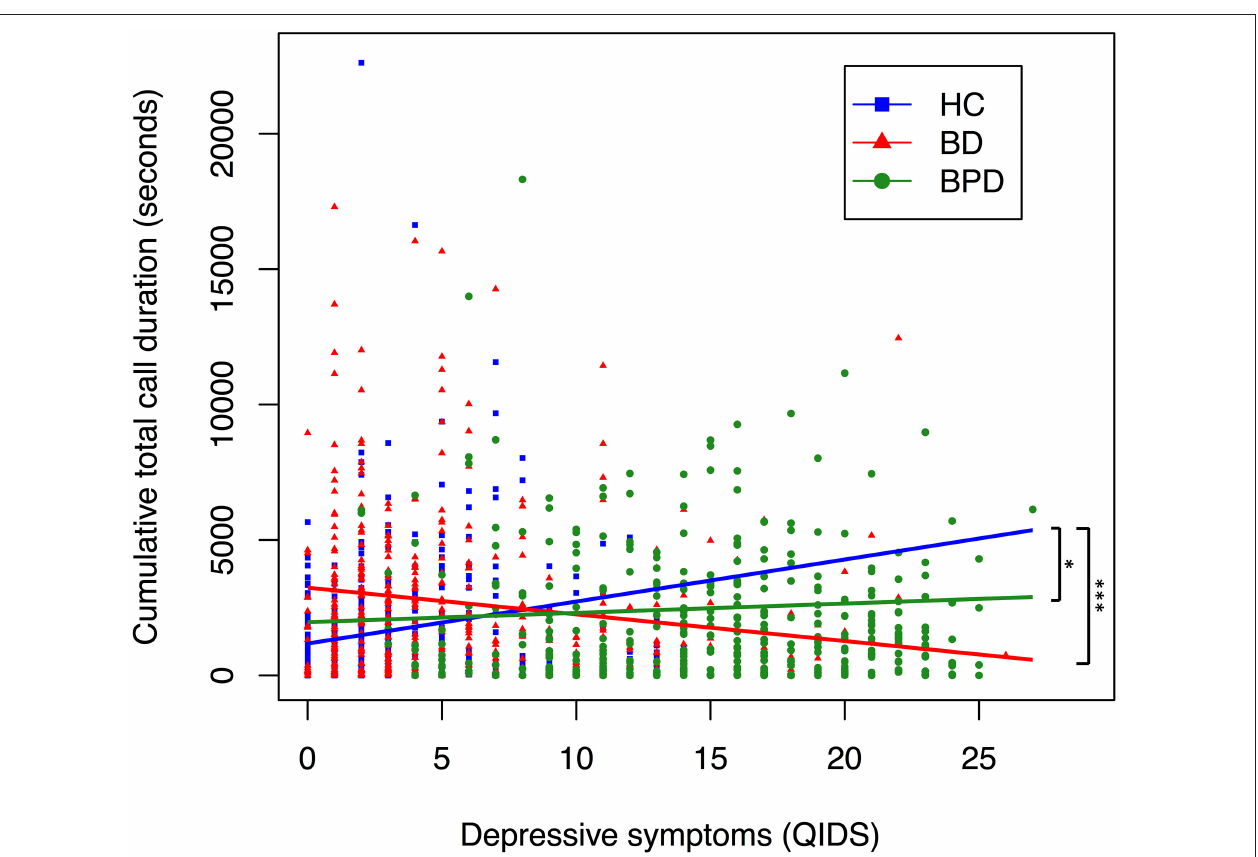
FIGURE 1 | Relationship between depressive symptoms and cumulative total call duration, by diagnostic group. A scatter plot displaying the relationship between depressive symptoms and cumulative total call duration. Each point corresponds to a participants’ depressive symptoms (measured by QIDS) and their cumulative total call duration (measured in seconds) in the 6 days preceding, and day of, a completed mood assessment. Color coding corresponds to diagnosis. Trendline coefficients are taken from linear mixed-effects regression models adjusted for age. Significance testing performed with HC as reference; *** p < 0.001, ** p < 0.01, * p < 0.05 (HC, n = 642; BD, n = 456; BPD, n =